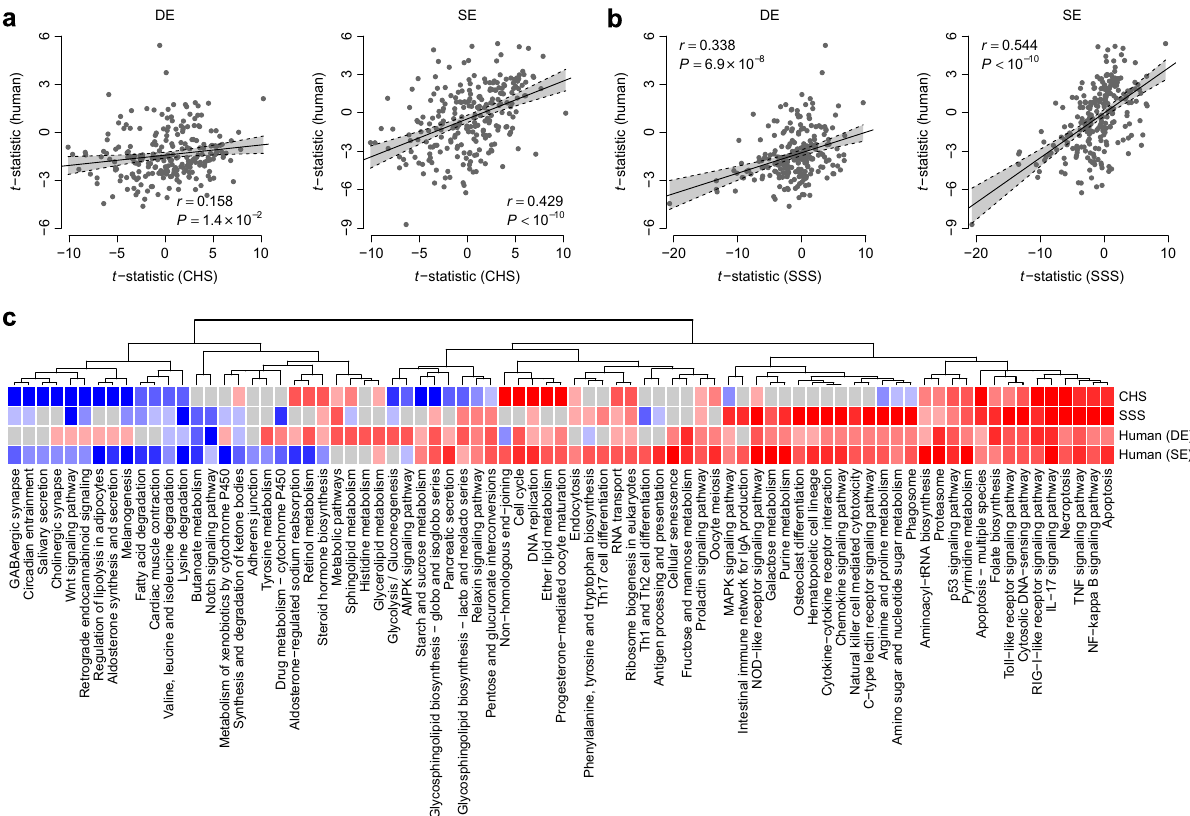
Figure 2. Kyoto Encyclopedia of Genes and Genomes (KEGG) pathway-level comparison between human cohorts and ( a ) contact hypersensitivity (CHS) model or ( b ) skin-scratching stimulation (SSS) model. Each dot represents one KEGG pathway. ( c ) Heatmap of the t-statistic. The red color indicates a positive t -statistic, and the blue color indicates a negative t